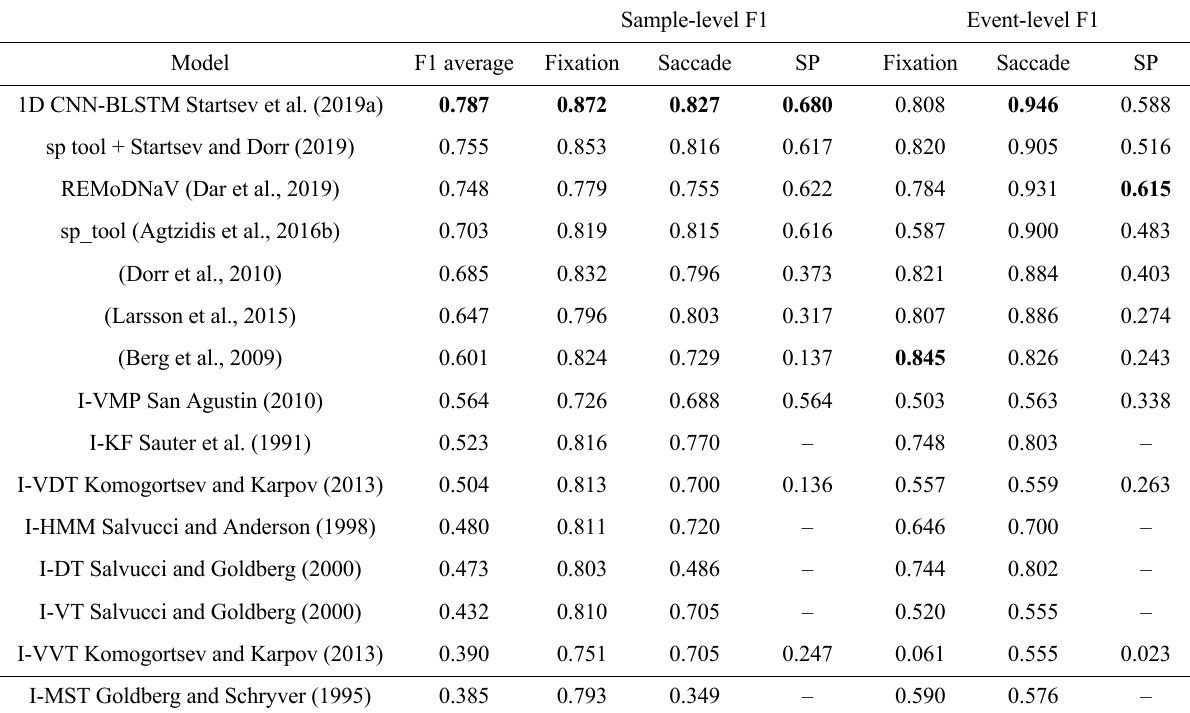
Table 1. Evaluation results for 15 publicly available eye movement classification algorithms. The order of presentation is based on the average